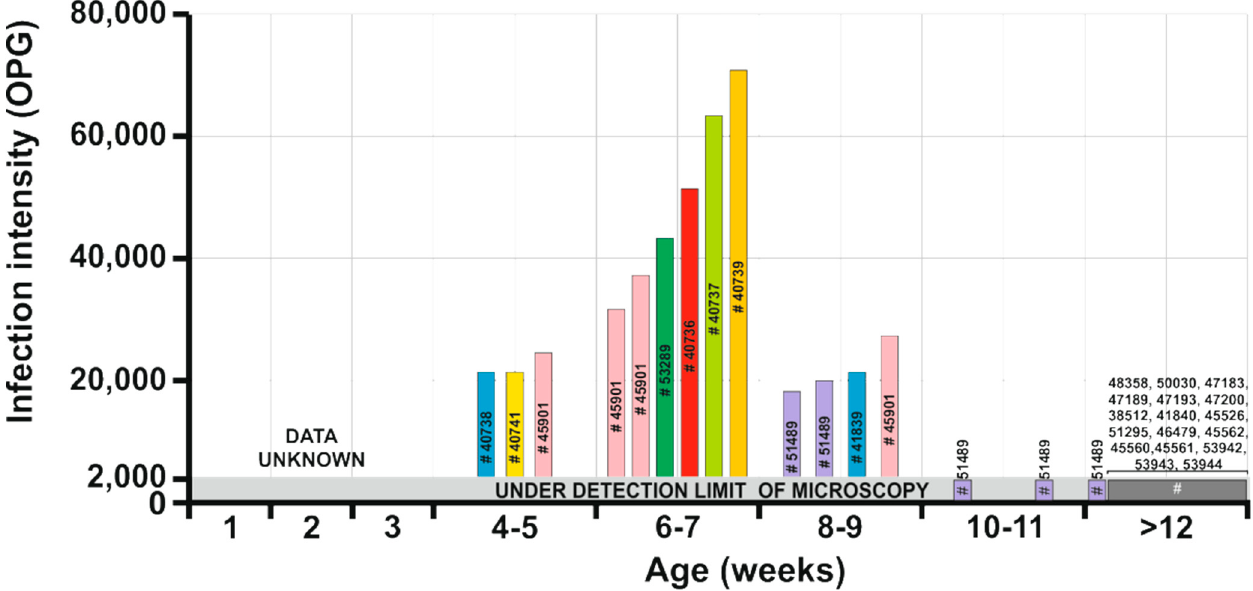
Figure 4. Infection intensity of Cryptosporidium sciurinum n. sp. in Eurasian red squirrels ( Sciurus vulgaris ) expressed as number of oocysts per gram of faeces (OPG). Data were collected from naturally infected Eurasian red squirrels. Animals aged 4–11 weeks old originated from rescue stations, and some of those animals were screened repeatedly (each animal is marked with a colour). The animal number (e.g., #45901) corresponds with the numbers in Table 1.